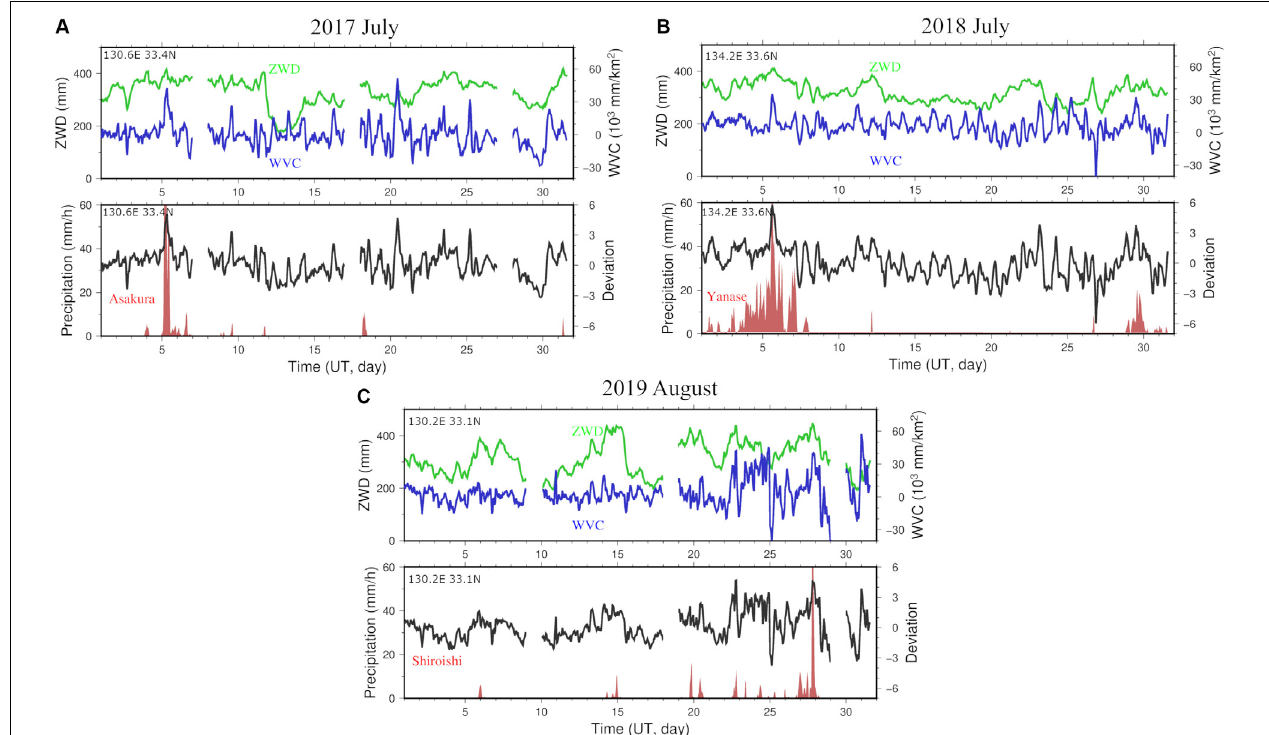
FIGURE 10 | Time series of the two quantities shown in Figure 8, WVC and sea level ZWD (blue and green in the top panels), and rain rate at the nearest AMEDAS stations (red in the bottom panels). The bottom panels also show a new quantity (labeled as “Deviation”) in black, the sum of the standard deviation of the two quantities. They are for July 2017 (A) , July 2018 (B) , and August 2019 (C) . High hourly rain rates occur when both the WVC and ZWD record very high values.